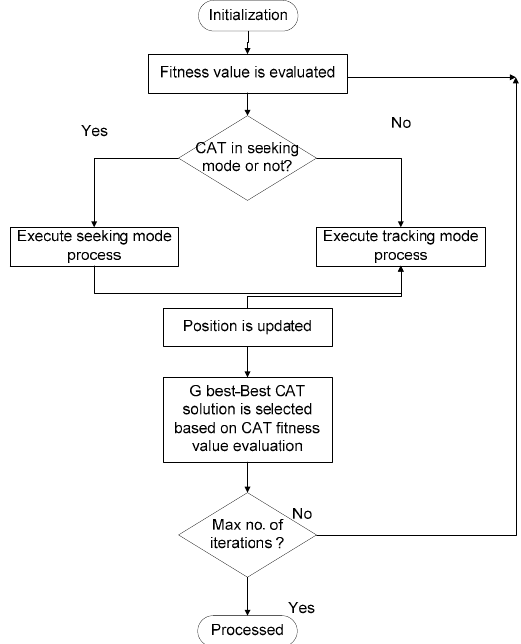
Figure 3. Flowchart of the enhanced cat swarm optimization algorithm.